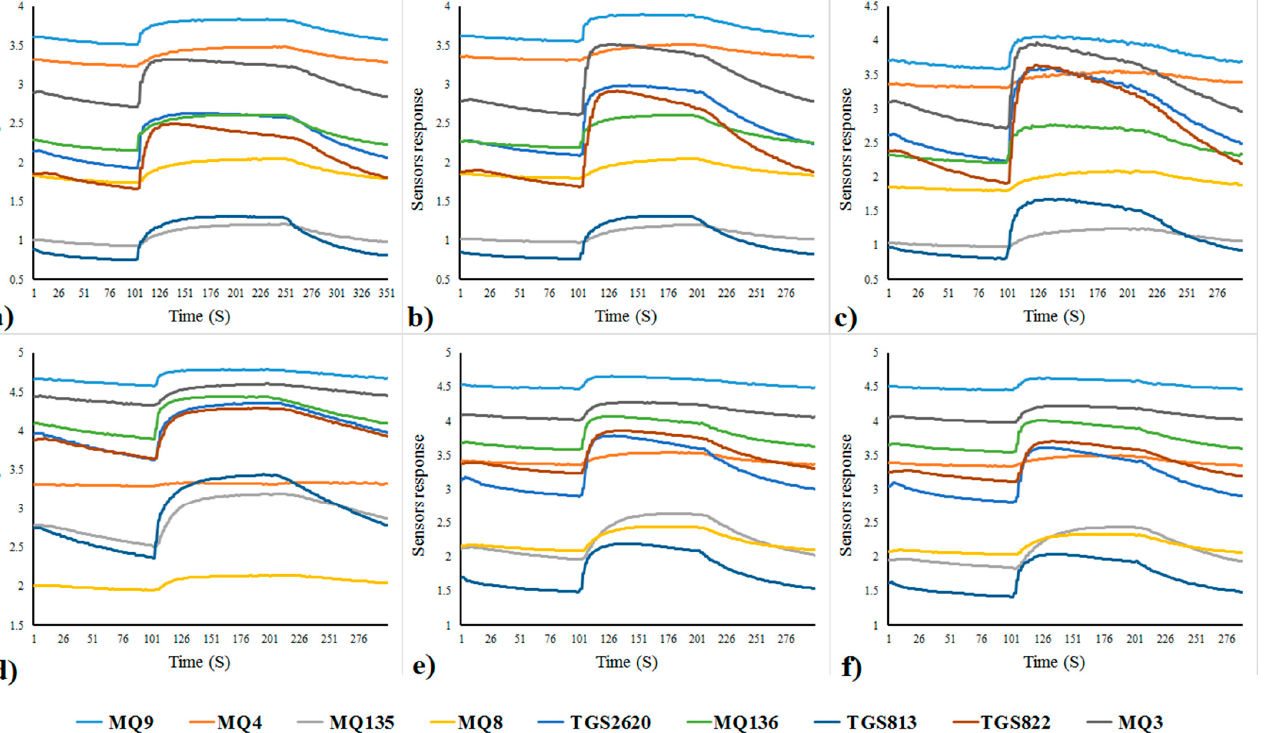
Figure A1. The aroma signatures (smellprint patterns) resulting from nine sensor-output responses of the MAU-9 electronic-nose system to aroma VOC-emissions of purified and concentrated herb and fruit essential oil samples. Sensor-array output pattern responses to individual plant essential oil sample types are as follows: ( a ) tarragon, ( b ) mint, ( c ) thyme, ( d ) mango, ( e ) orange and ( f ) lemon.